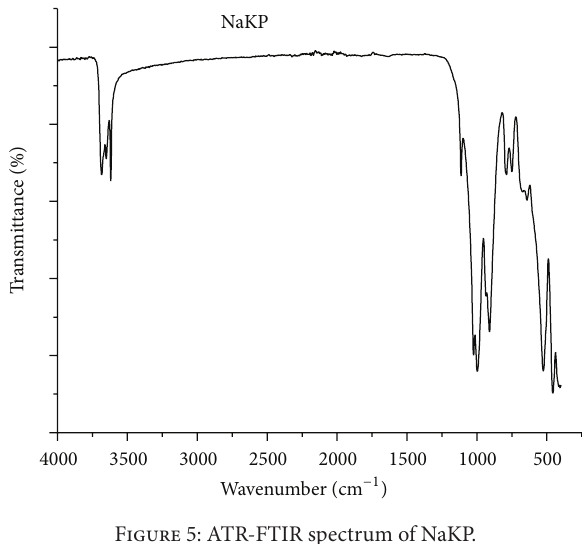
Figure 5: ATR-FTIR spectrum of NaKP.